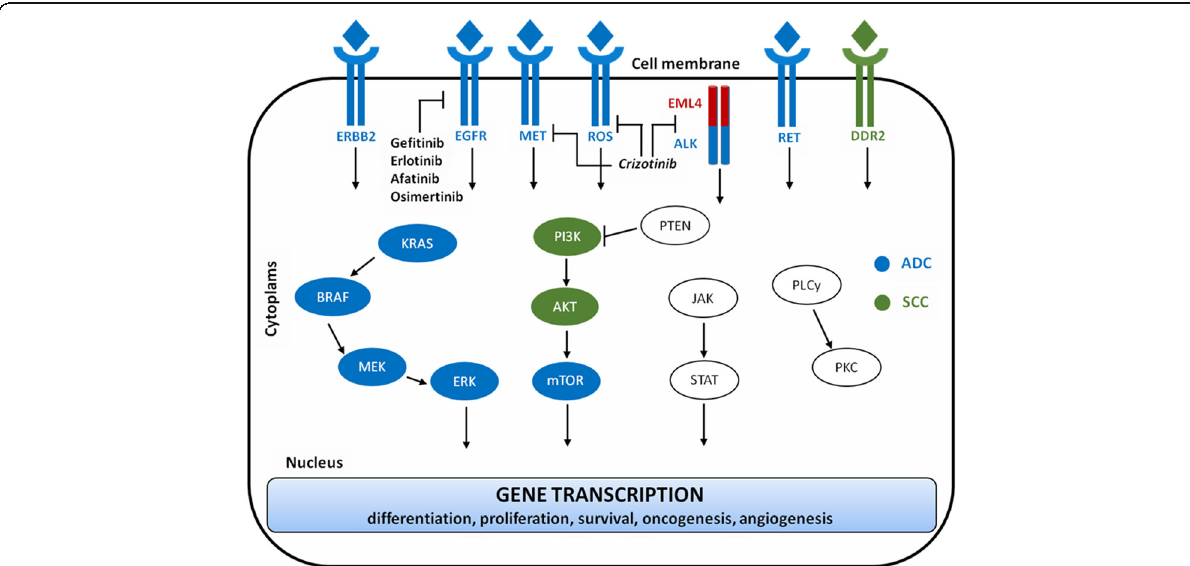
Fig. 1 Simplified schema of the most frequently altered signaling pathways in NSCLC. Blue and green ovals indicate the proteins commonly activated in ADC and SSC, respectively. Druggable TKIs and approved targeted agents are